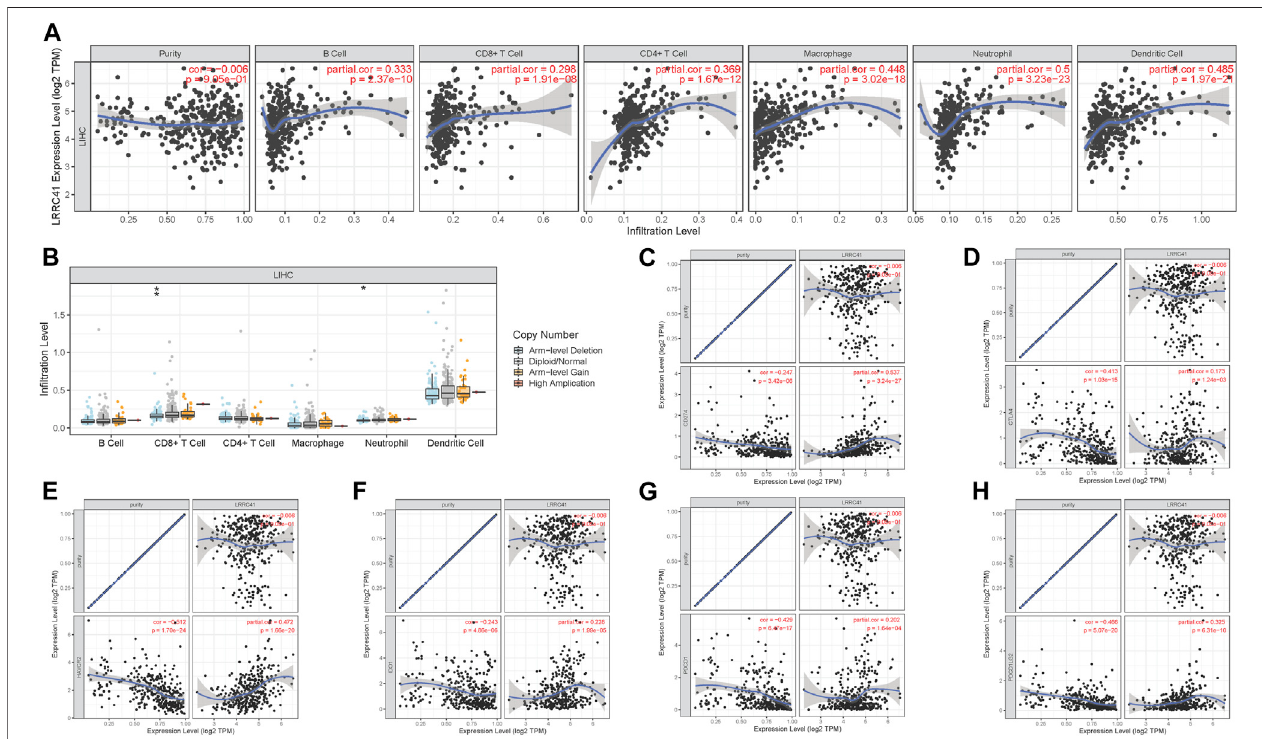
FIGURE 8 | Role of LRRC41 in TIME and immunotherapy of HCC. (A) Correlation analysis of LRRC41 expression level with in fi ltrating B cells, CD4 + T cells, CD8 + T cells, dendritic cells, macrophages, and neutrophils using TIMER. (B) Comparison of tumor in fi ltration levels among HCC samples with different somatic copy number alterations in LRRC41. The association between the expression levels of LRRC41 and CD274 (C) , CTLA4 (D) , HAVCR2 (E) , IDO1 (F) , PDCD1 (G) , and PDCD1LG2 (H) using